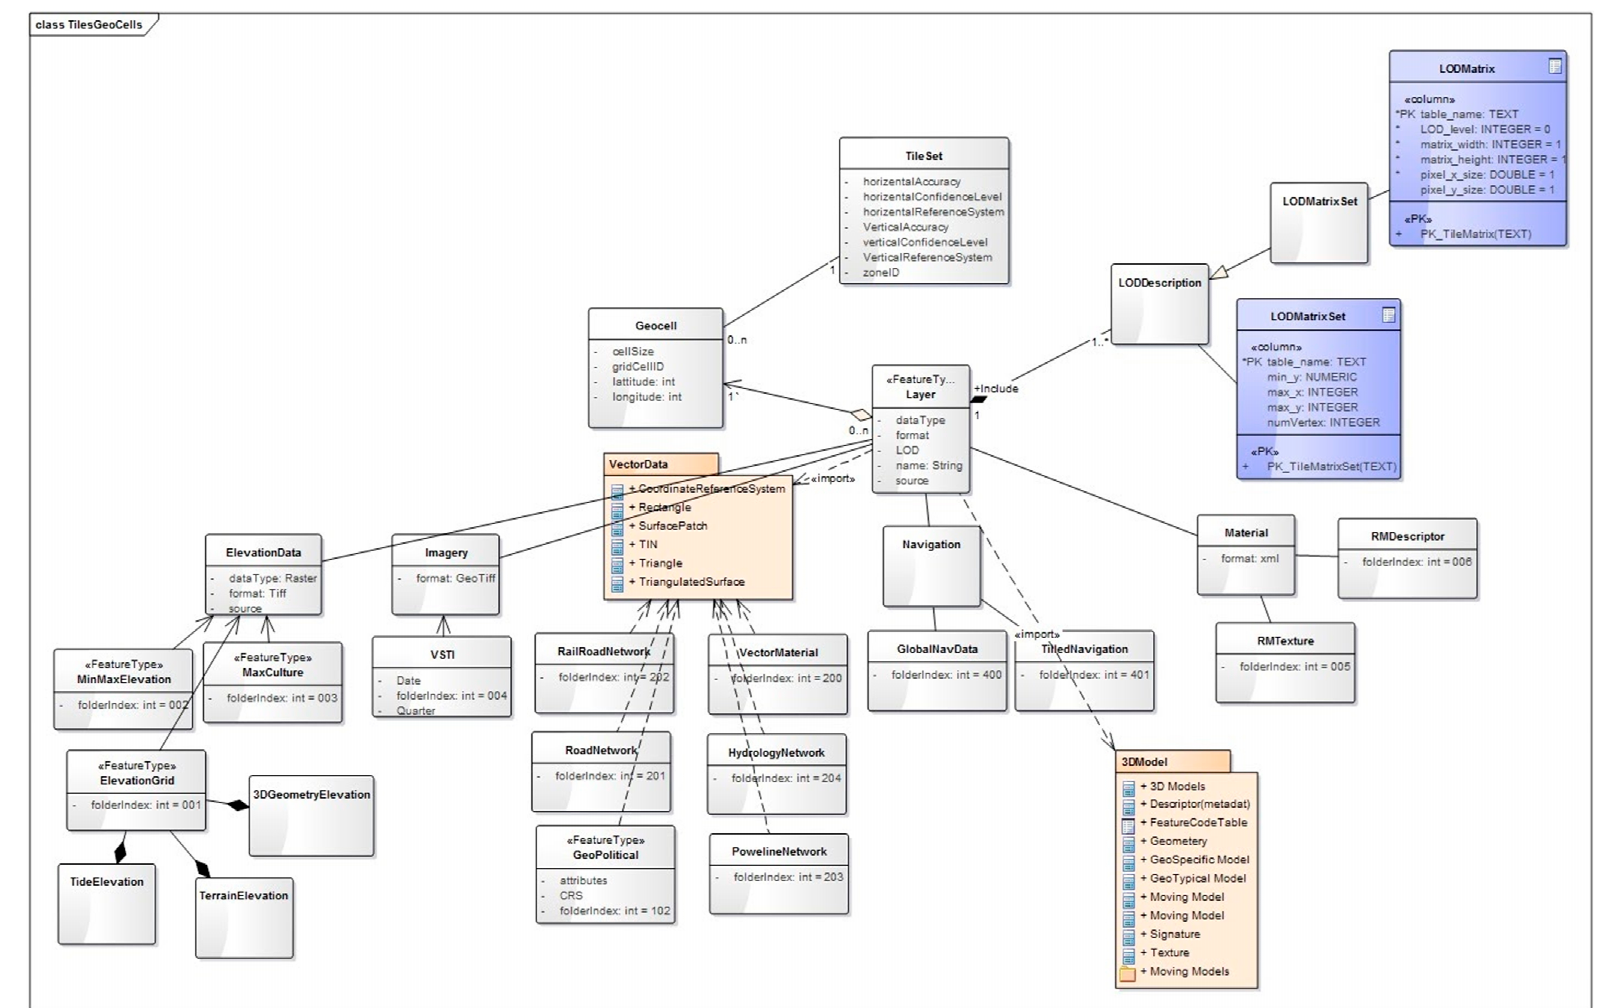
Figure 4. UML diagram of the OGC CDB general data